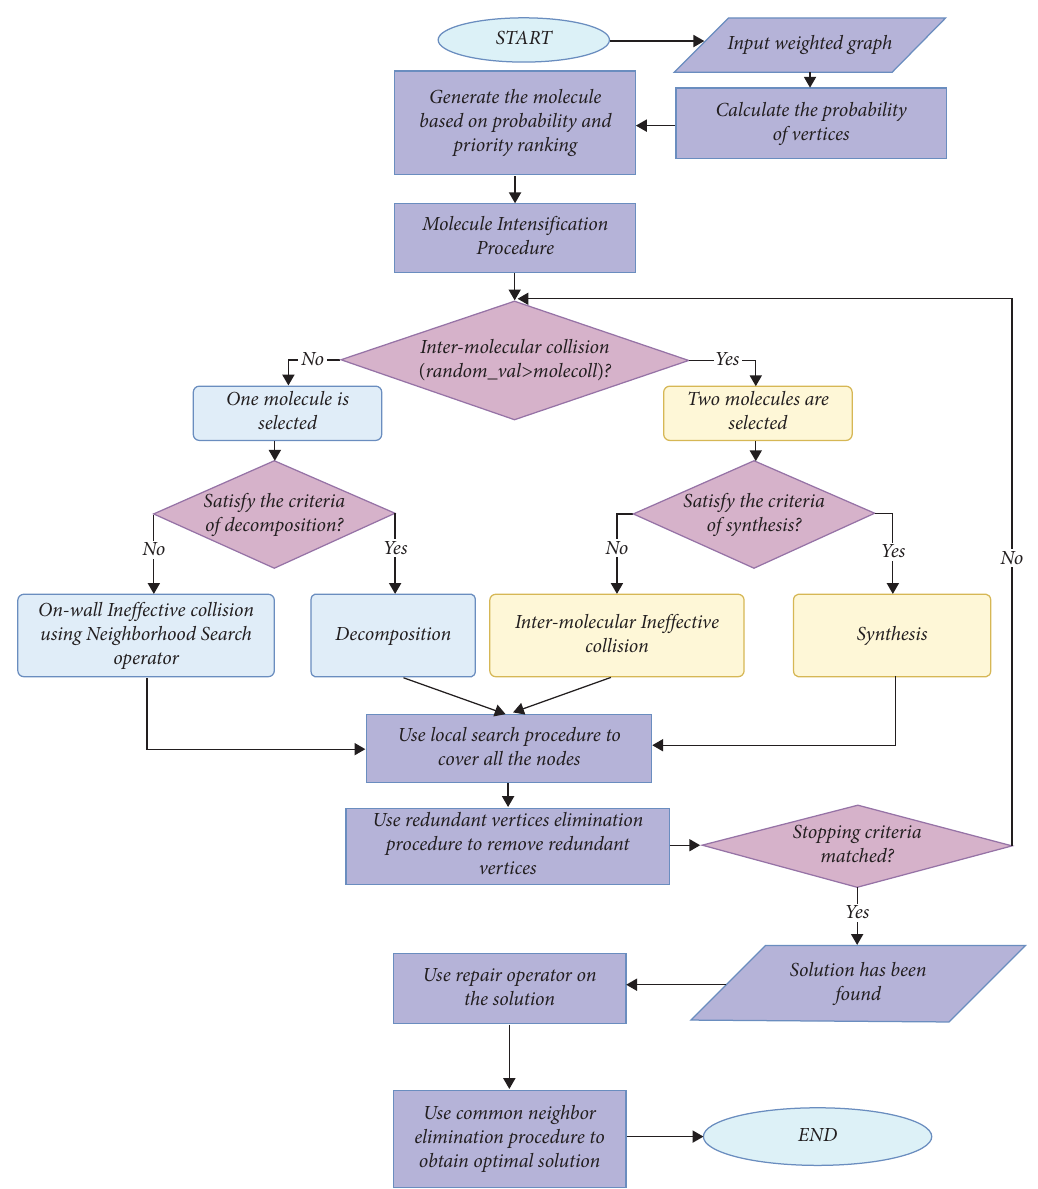
Figure 9: Flowchart of CRO for MWDS